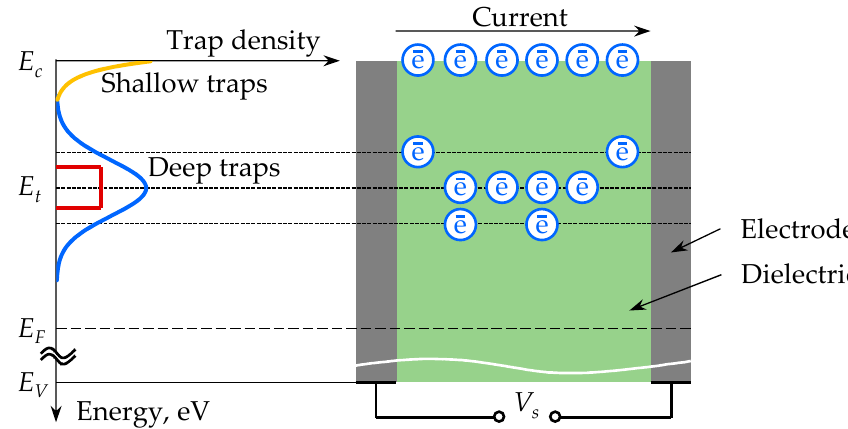
Figure 1. A simplified diagram to explain electron trapping. E c —the bottom of the conduction band; E t —activation energy of deep traps; E F —Fermi level; E V —the top of the valence band. V S is the voltage applied to the electrodes of the structure. The energy range between EC and EV is called the band gap ( E g ). The energy levels for shallow traps as well as hole trapping are not shown.